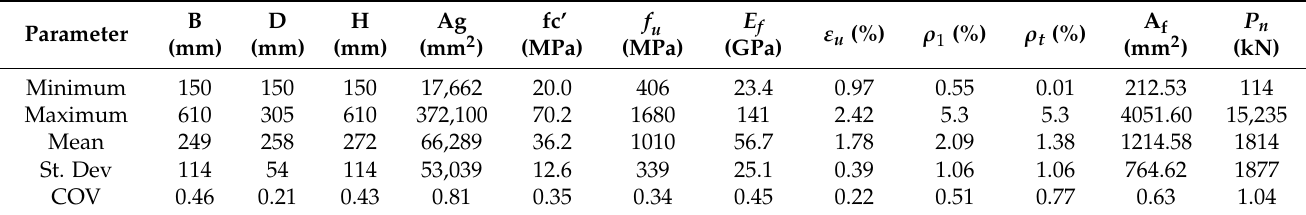
Table 6. Statistical indices of developed database (COV represents the coefficient of variance and St. Dev represents the standard